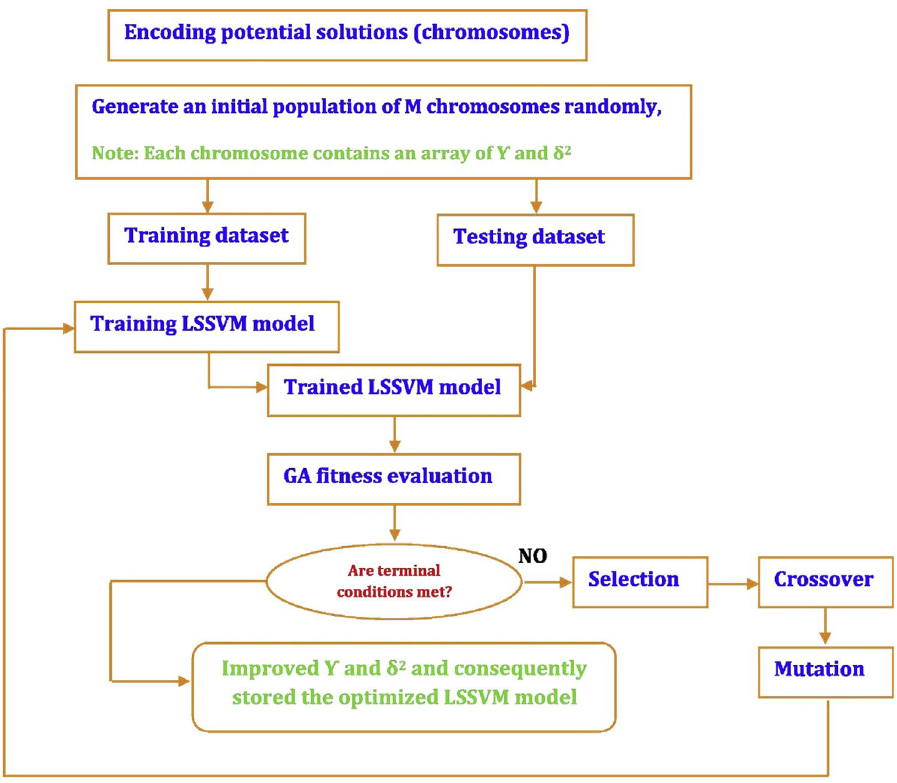
Figure 2. Schematic representation of the GA-LSSVM method 60